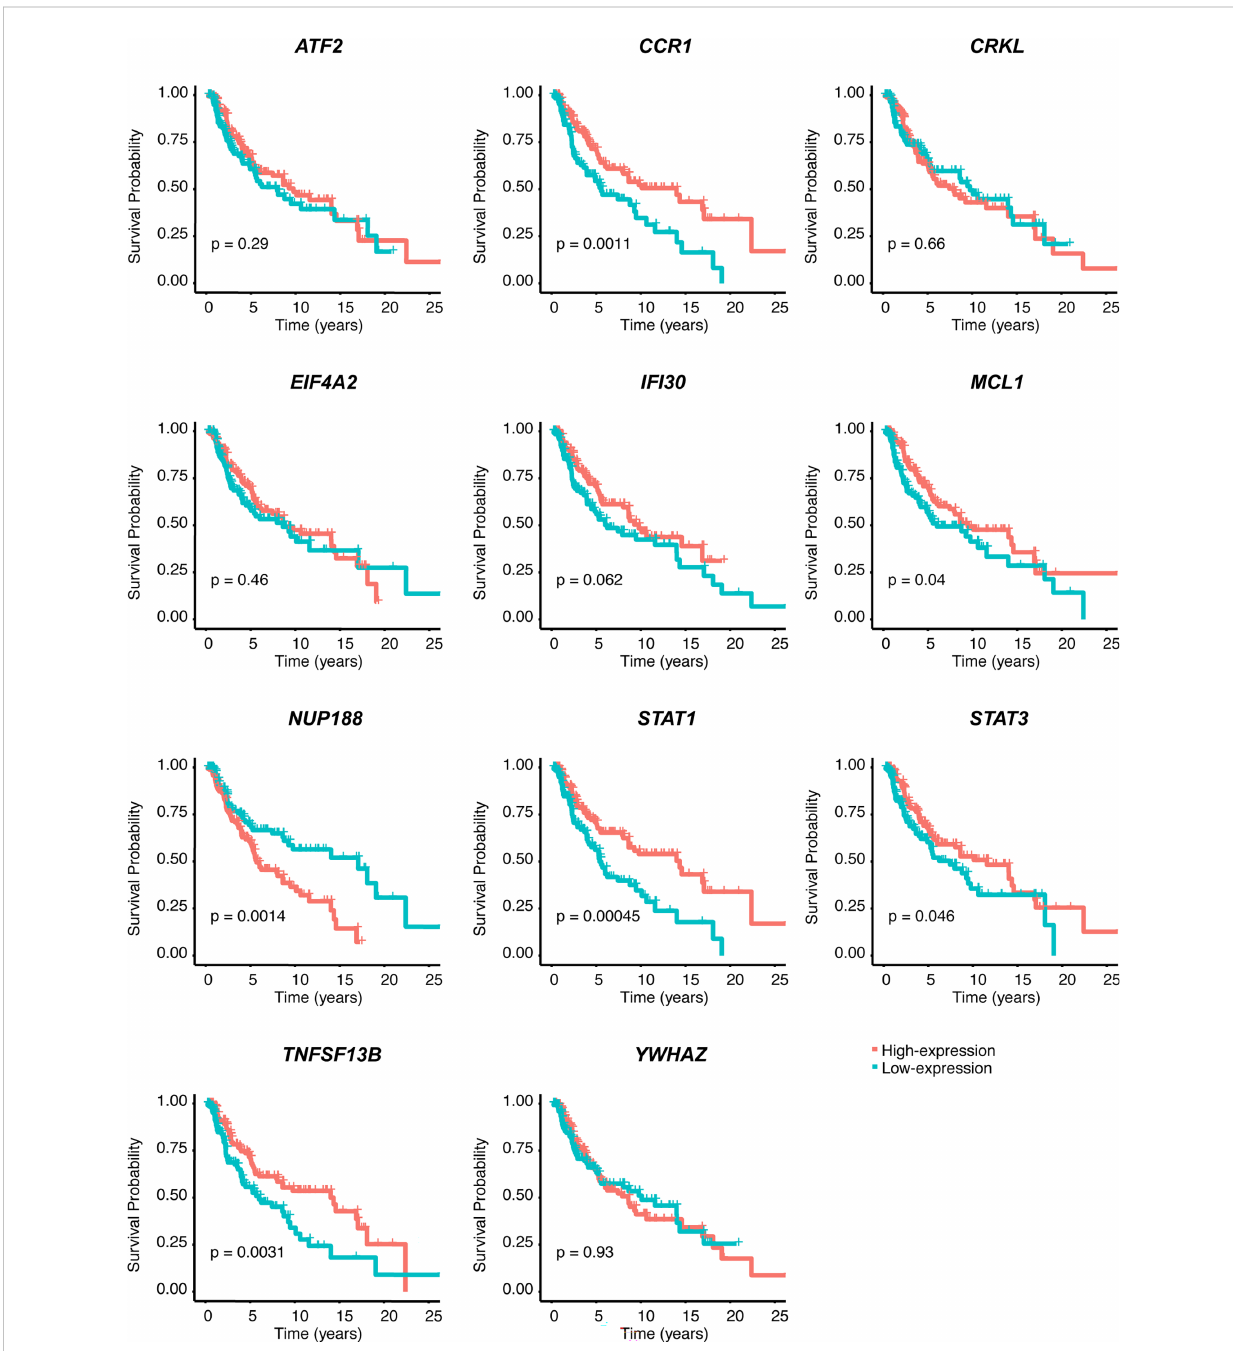
FIGURE 3 Kaplan – Meier survival analysis of 11 CSIRGs, including ATF2, CCR1, CRKL, EIF4A2, IFI30, MCL1, NUP188, STAT1, STAT3, TNFSF13B, and YWHAZ , identi fi ed by LASSO regression in the TCGA-SKCM